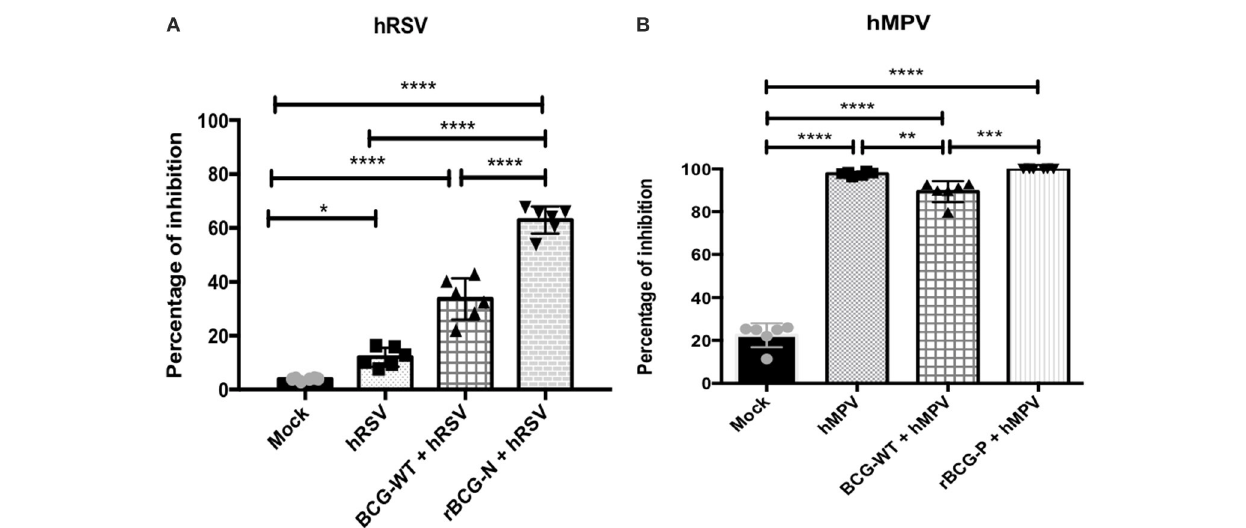
FIGURE 5 | Sera from immunized mice are able to neutralize both viruses in vitro . Sera pools from all experimental groups were incubated with the GFP-virus and then used to infected cells to evaluate whether they have the ability to neutralize viral replication. The effect was measured counting the plaques forming units (PFUs) induced by each GFP- virus and indicated as percentage of inhibition. The effect observed from the sera of the hRSV-infected animals was evaluated at 14 dpi (A) and the effect from hMPV-infected animals was evaluated at 49 dpi (B) . The bars observed in the (A) are accordingly: Mock-treated, hRSV-infected, BCG-WT + hRSV, and rBCG-N + hRSV. On the other hand, the bars observed in (B) are accordingly: Mock-treated, hMPV-infected, BCG-WT + hMPV, and rBCG-P + hMPV. N = 3 for each group, with two independent experiments. Differences were evaluated by a one-way ANOVA (* p ≤ 0.05; ** p ≤ 0.01; *** p ≤ 0.001; *** p ≤ 0.0001). The error bars represent the Standard Deviation